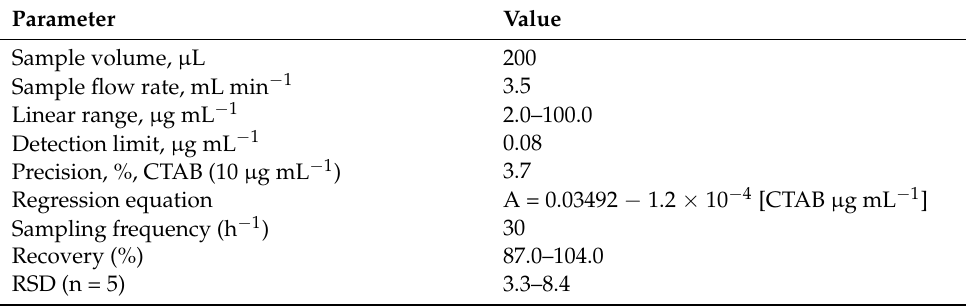
Table 5. Analytical performance data of the proposed Cu-PCV for determination of CTAB.